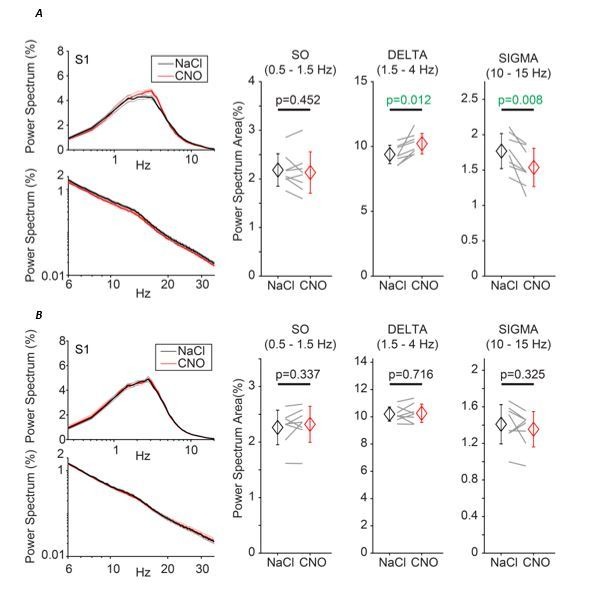
(A) Effects of chemogenetic hyperpolarization of PV-expressing TRN cells, experiment and analysis as described in Figure 4.(B) Effects of chemogenetic hyperpolarization of SOM-expressing TRN cells, experiment and analysis as described in Figure 4.